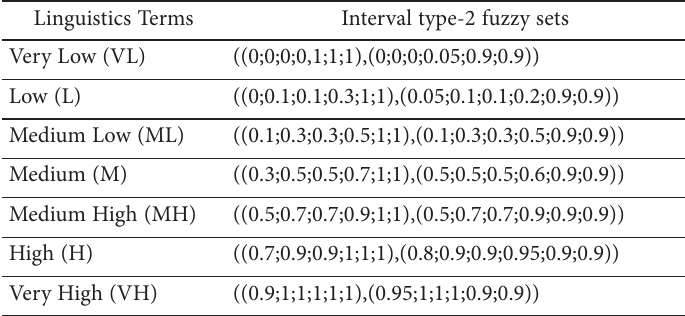
Table 5. Linguistic terms and their corresponding interval type-2 fuzzy sets Linguistics Terms Interval type-2 fuzzy sets